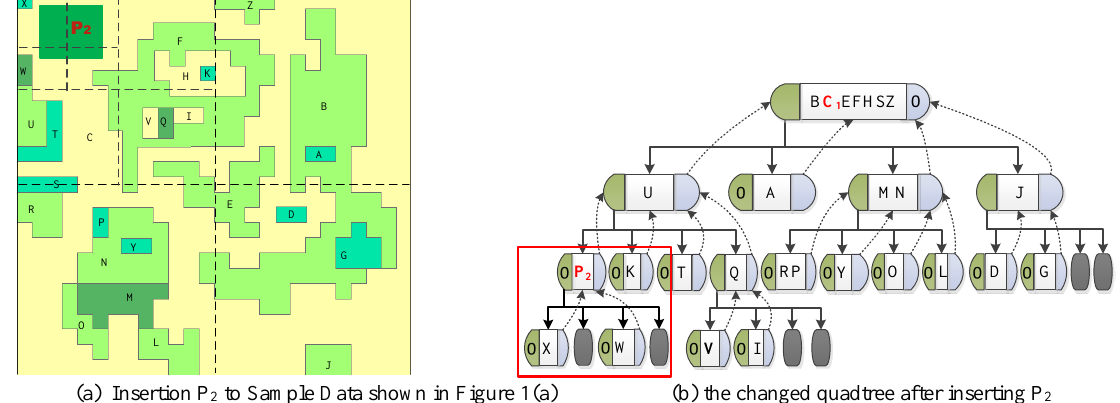
Figure 3. Index tree after inserting P 2 to the sample data shown in Figure